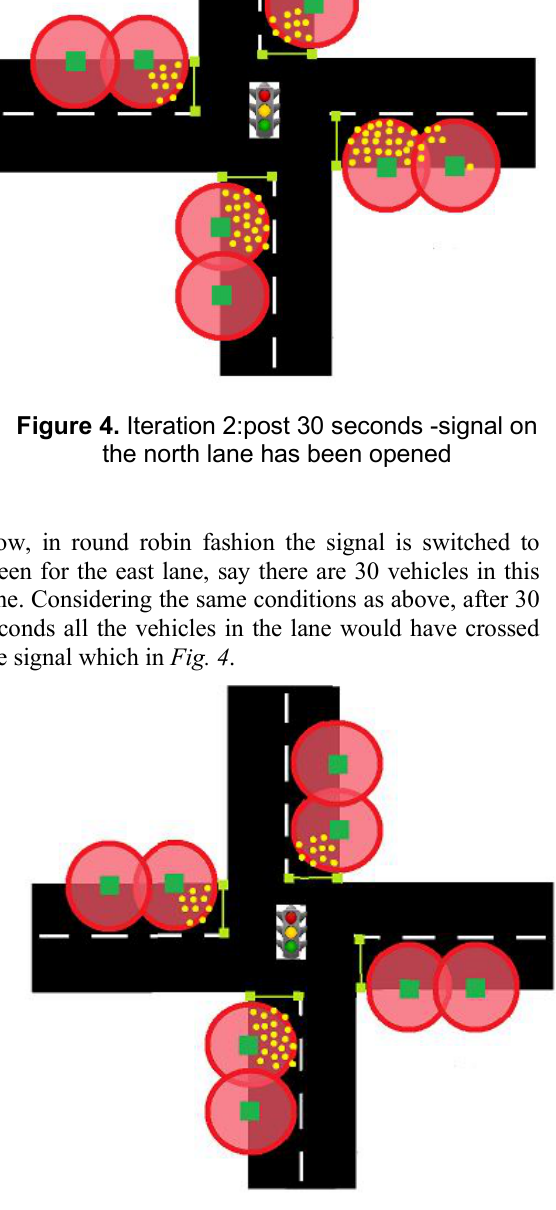
Figure 5. Iteration 3:post 30 seconds -signal on the east lane has been opened